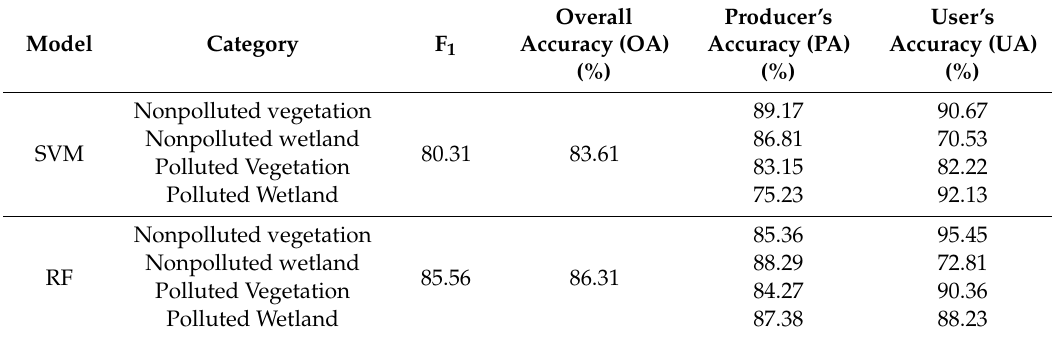
Table 7. Accuracy matrix value for SVM and RF for the pollution and other categories classification for a larger land area (Kota-Tinggi, Pontian, Johor Baharu and part of Keluang).